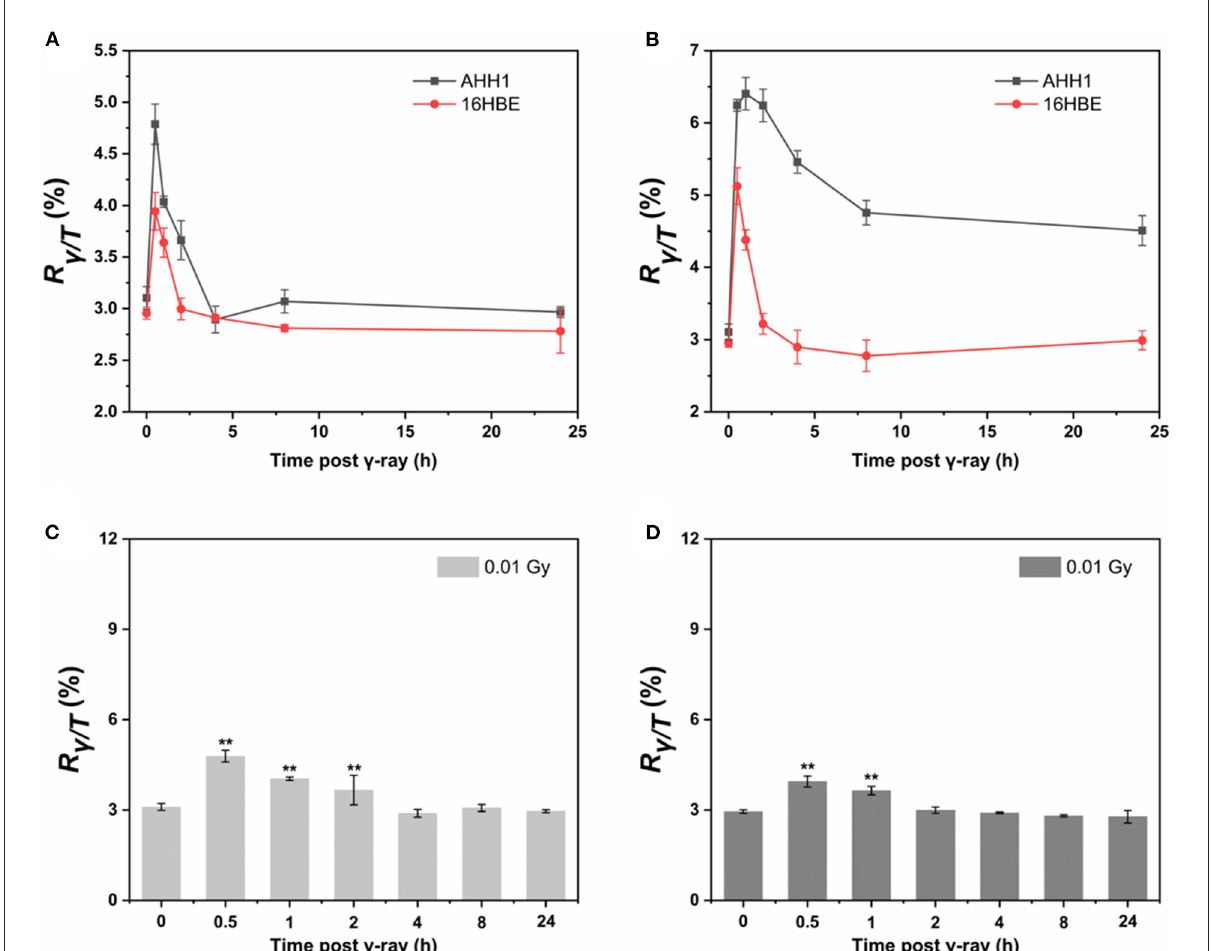
FIGURE2 Time courses of γ -H2AX in AHH1 and 16HBE cells treated with (A) 0.01Gy and (B) 0.2Gy of γ -ray irradiation for six time points: 0.5, 1, 2, 4, 8 and 24h. Time courses of γ -H2AX in (C) AHH1 and (D) 16HBE cells treated with 0.01Gy of γ -ray irradiation for six time points: 0.5, 1, 2, 4, 8 and 24h. The horizontal axis represents the exposure time for γ -ray, and the vertical axis represents the proportion of the number of phosphorylated peptides to the total number of peptides in a cell ( n ≥ 3, mean ± SD, ** p ≤ 0.01).